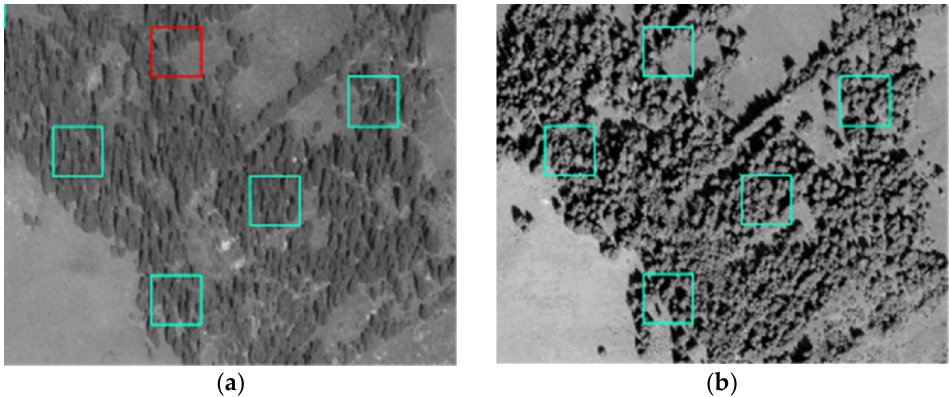
Figure 15. ( a ): Img_T1 (1980) and ( b ): Img_T2 (2009). Disagreement of the class “dense forest” between the CNN and visual image interpretation due to image distortion in study area 1. While blue-green image patches correspond to agreement of the class “dense forest”, red image patches correspond to disagreement.